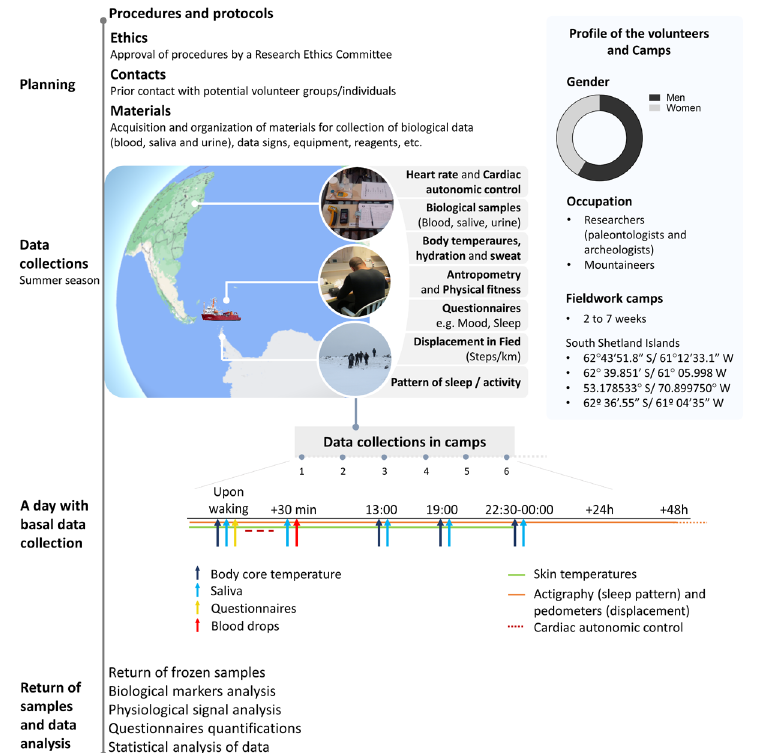
Figure 1. Overview of human biology-research methods in Antarctica. Milestones of a data collection. (i) Planning ; including approval by a Research Ethics Committee. The volunteers are informed about the objectives and experimental procedures and are free to decide, at any time, not to participate in any procedure or the entire data collection without providing explanations. (ii) The locations for data collection in the summer period in Antarctica; data collection occurs in Antarctic field period and, when possible, in pre-and post-field moments on the ship, or even in laboratory-controlled environmental conditions in Brazil (15 to 30 days before the expedition and after return). For the participants’ physical characterization, anthropometric characteristics are usually evaluated. We performed collections of biological samples (e.g., blood, saliva, and urine), cardiac autonomic control measures, temperatures, and mood states using questionnaires. To assess physical fitness, incremental tests to estimate aerobic capacity are conducted on the ship (to estimate their V̊O and to assess HR at submaximal intensities) 2MAX or in laboratories in Brazil (by direct measure of V̊O (for detailed technical protocols, see Moraes et al. 2018, 2MAX) 2020, 2021, Martins et al. in press). (iii) Timeline representing a day with basal data collections in Antarctica; the collections of biological materials occur in the morning and, if necessary, at other time points of the day. Also, morning resting heart rate variability measures are obtained to assess autonomic control. To assist in the understanding of the variables, the participants are asked to answer a mood questionnaire. We also accompany the volunteers over field activities, during which we evaluate the intensity of effort and thermoregulatory responses, and monitor the daily displacement of the participants. For thermoregulatory monitoring, we measure skin temperatures by contact sensors attached to the participant’s body and by infrared thermometer for the skin exposed area (i.e., face). However, a defy is the measurement of internal temperature. A practical and wireless method that allows monitoring the internal temperature while working in the field for long hours is the use of ingestible capsules for measurement by telemetry. We performed this measure in fieldwork camps on individuals who had previously ingested a capsule in Brazil. To these methods previously used in the aforementioned works, others were added (results not yet published), such as the measure of the activity pattern over 24 hours, to evaluate the sleep/wake cycle, by actigraphy (a clock-shaped device) throughout the measurement period. (iv) After data collection and return of samples and data analysis , samples and data are processed considering fieldwork’s specific conditions. The number of volunteers in camps varied between 7 to 10 [8.2 ± 1.3 (average data and standard deviation)]. Of these, 41.5% of the participants were women [in each camp, the number of women varied from 30 to 62% (including data not yet